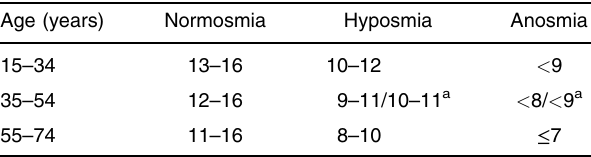
Table 1 Scandinavian Odor Identification Test age and sex cutoff